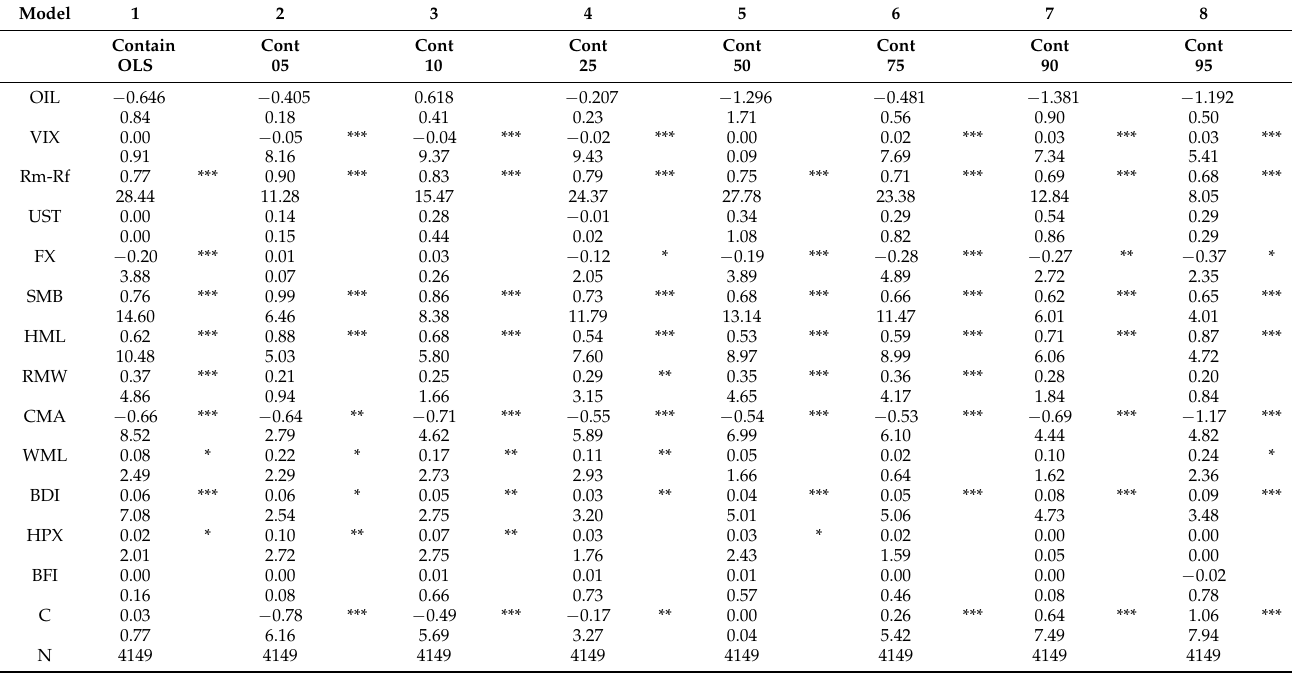
Table 6. Ordinary least square (OLS) and quantile regression estimates for the container sector.